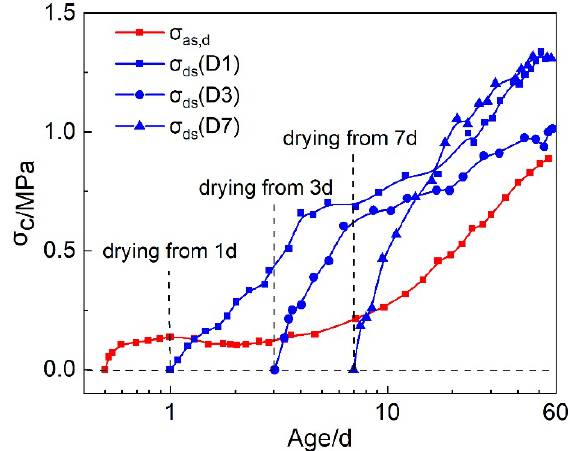
Figure 7. The development of the autogenous shrinkage stress and drying shrinkage stress under rebar restraint and di ff erent drying